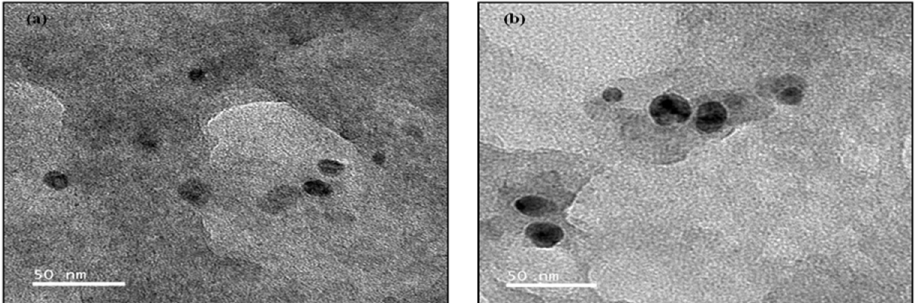
Figure 4. Transmission electron microscope (TEM) image ( a , b ) of Diosgenin-loaded nanoparticles (PCL-F68-D-NPs).